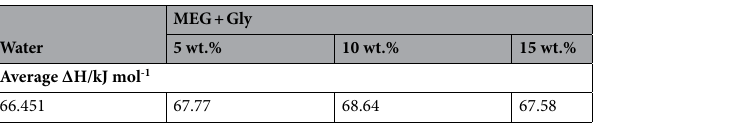
Table 1. Molar dissociation enthalpies of carbon dioxide hydrate in the absence and presence of different chemical additives.